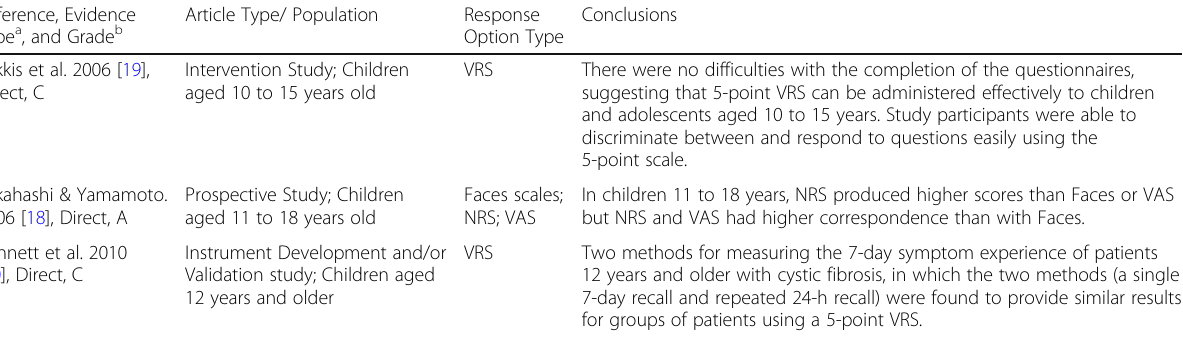
Table 5 Summary of key evidence to support response scale selection for children 10 to 18 years old Reference, Evidence Type a , and Grade